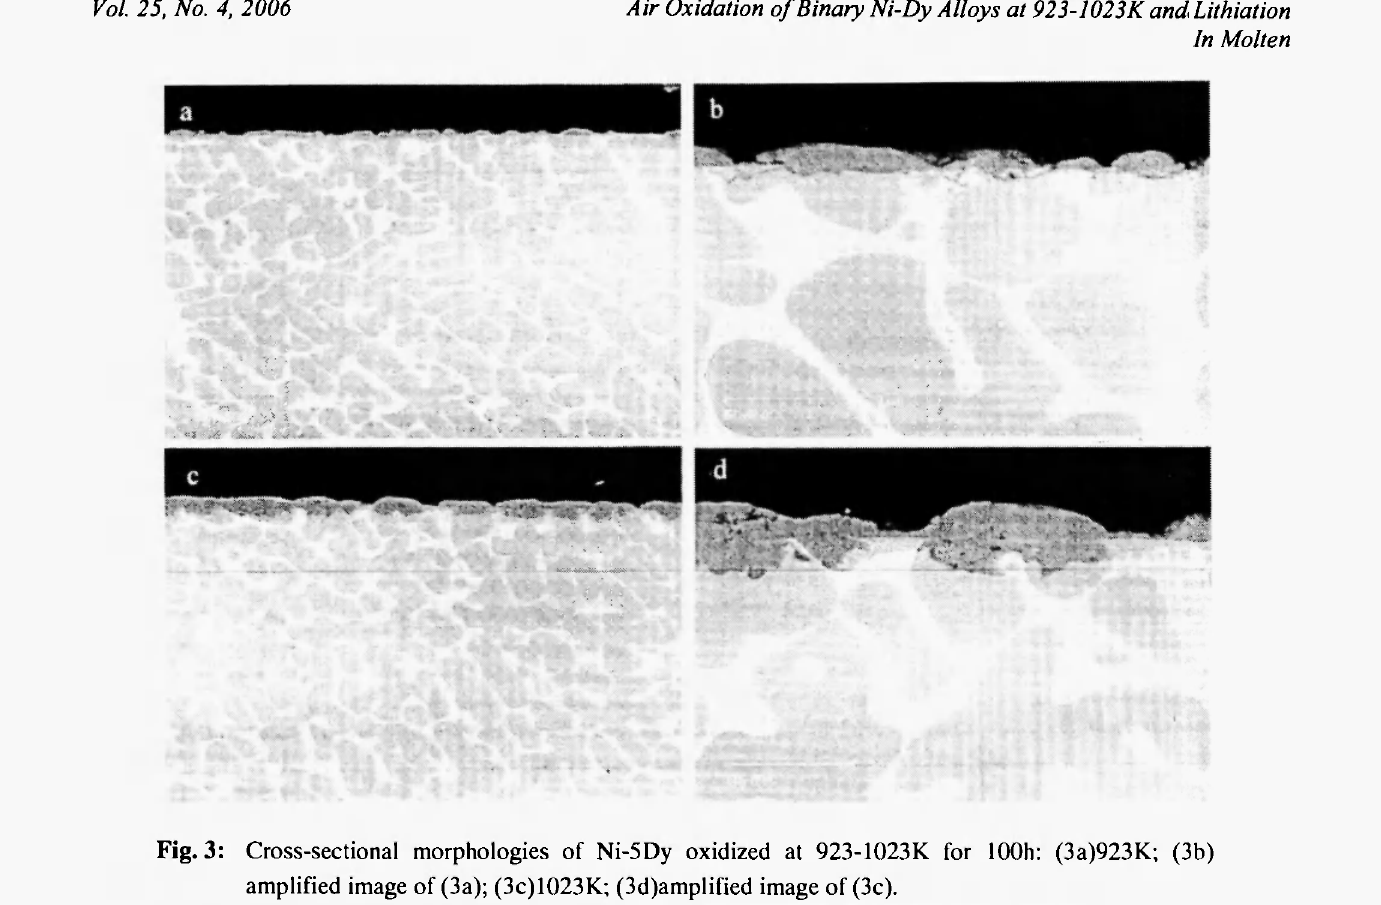
Fig. 3: Cross-sectional morphologies of Ni-5Dy oxidized at 923-1023K for 100h: (3a)923K; (3b) amplified image of (3a); (3c)1023K; (3d)amplified image of (3c).